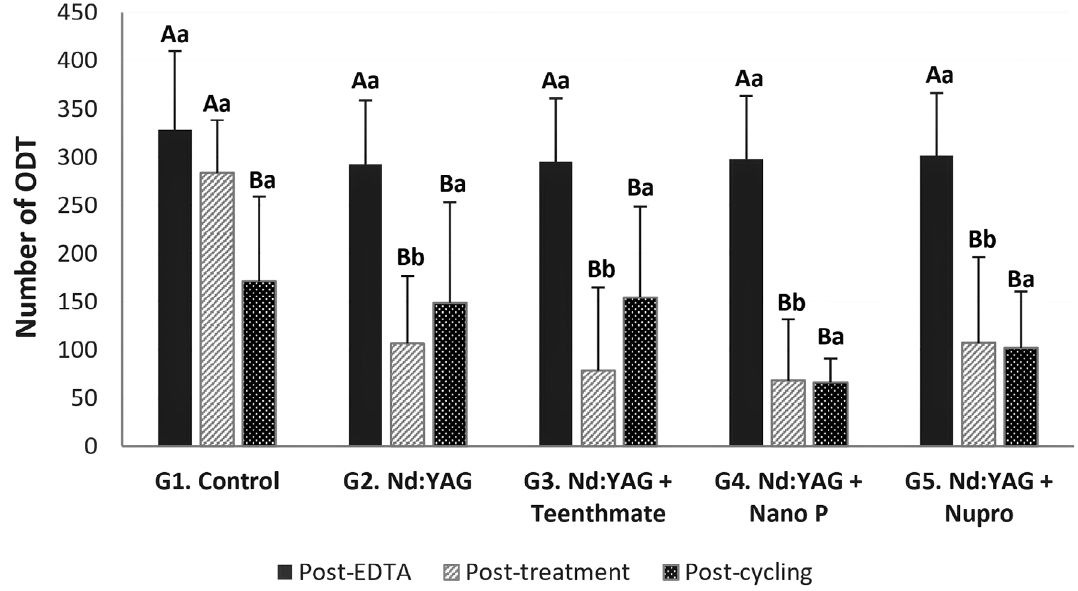
Figure 3- Means (standard deviations) of ODT for all groups in all experimental moments. Different Capital letters imply differences between experimental moments within groups (p≤0.05). Different lowercase letters denote differences among groups within moments (p≤0.05)